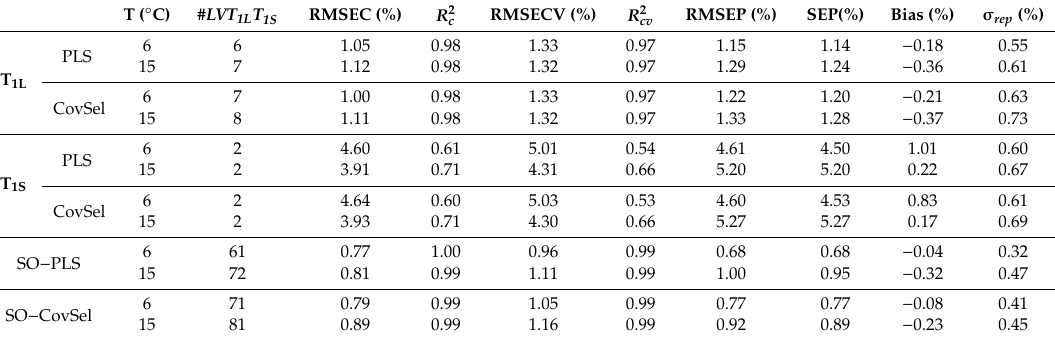
Table 2. Figures of merit of the models at the two di ff erent temperatures. R 2 x are the square correlation coe ffi cients between actual and predicted values, σ rep is the standard deviation of repeatability calculated on the triplicates. #LV is the number of variables used in the